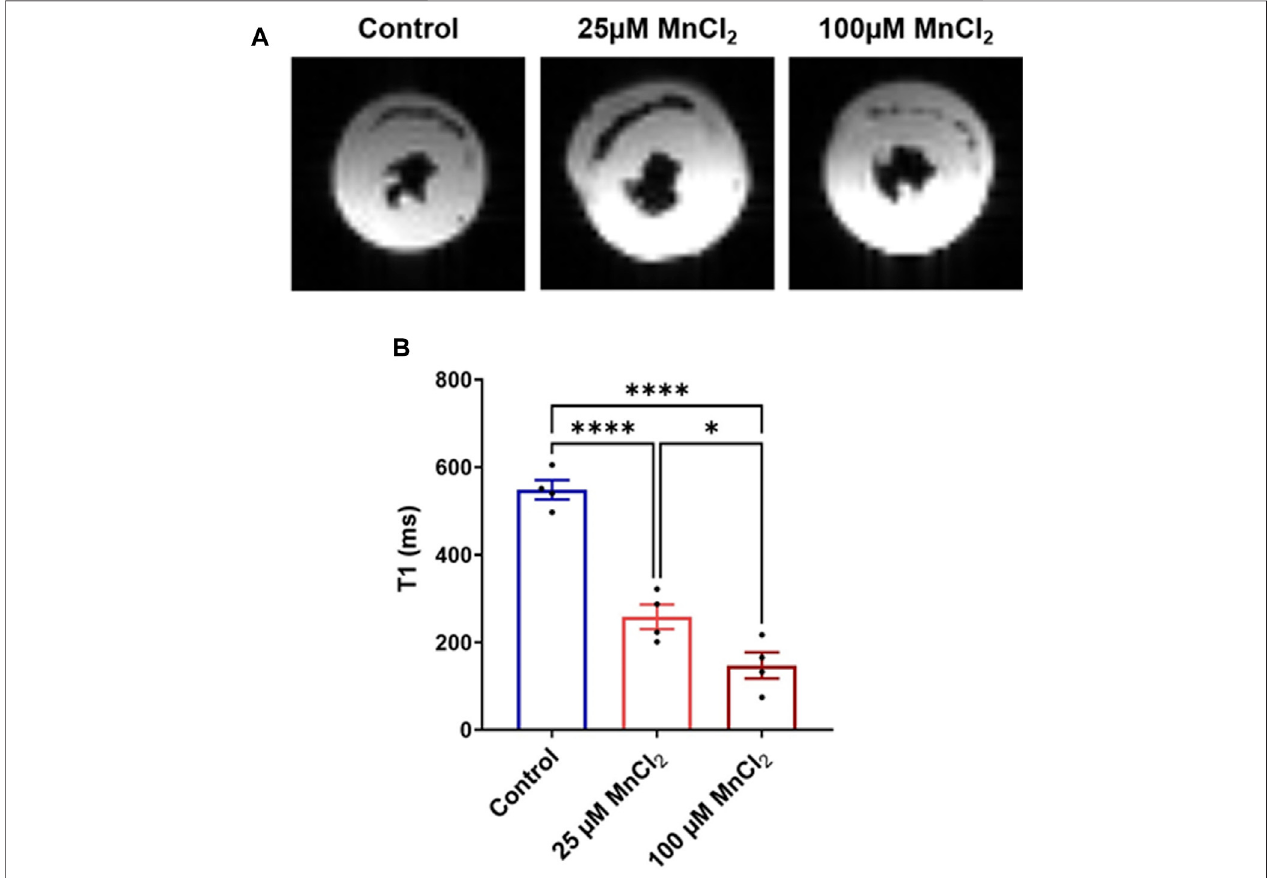
FIGURE6 | Effect of MnCl 2 on T1 longitudinal relaxation time ofmyocardial tissue at 1.5T MRI. (A) Typical MR images ofperfused rat hearts (mid-ventricular short- axis view) (B) T1 relaxation time of control condition ( N = 4) compared to 25 µM ( N = 4) and 100 µM ( N = 4) of MnCl 2 . * p < 0.05, **** p < 0.0001.